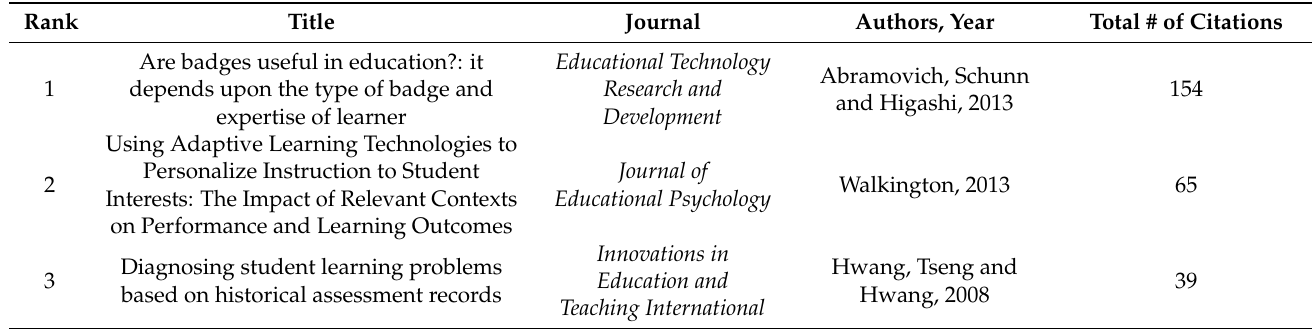
Figure 4. Top 9 journals by total number of publications from 1996 to 2020 (note: only journals with 2 or more publications are included).